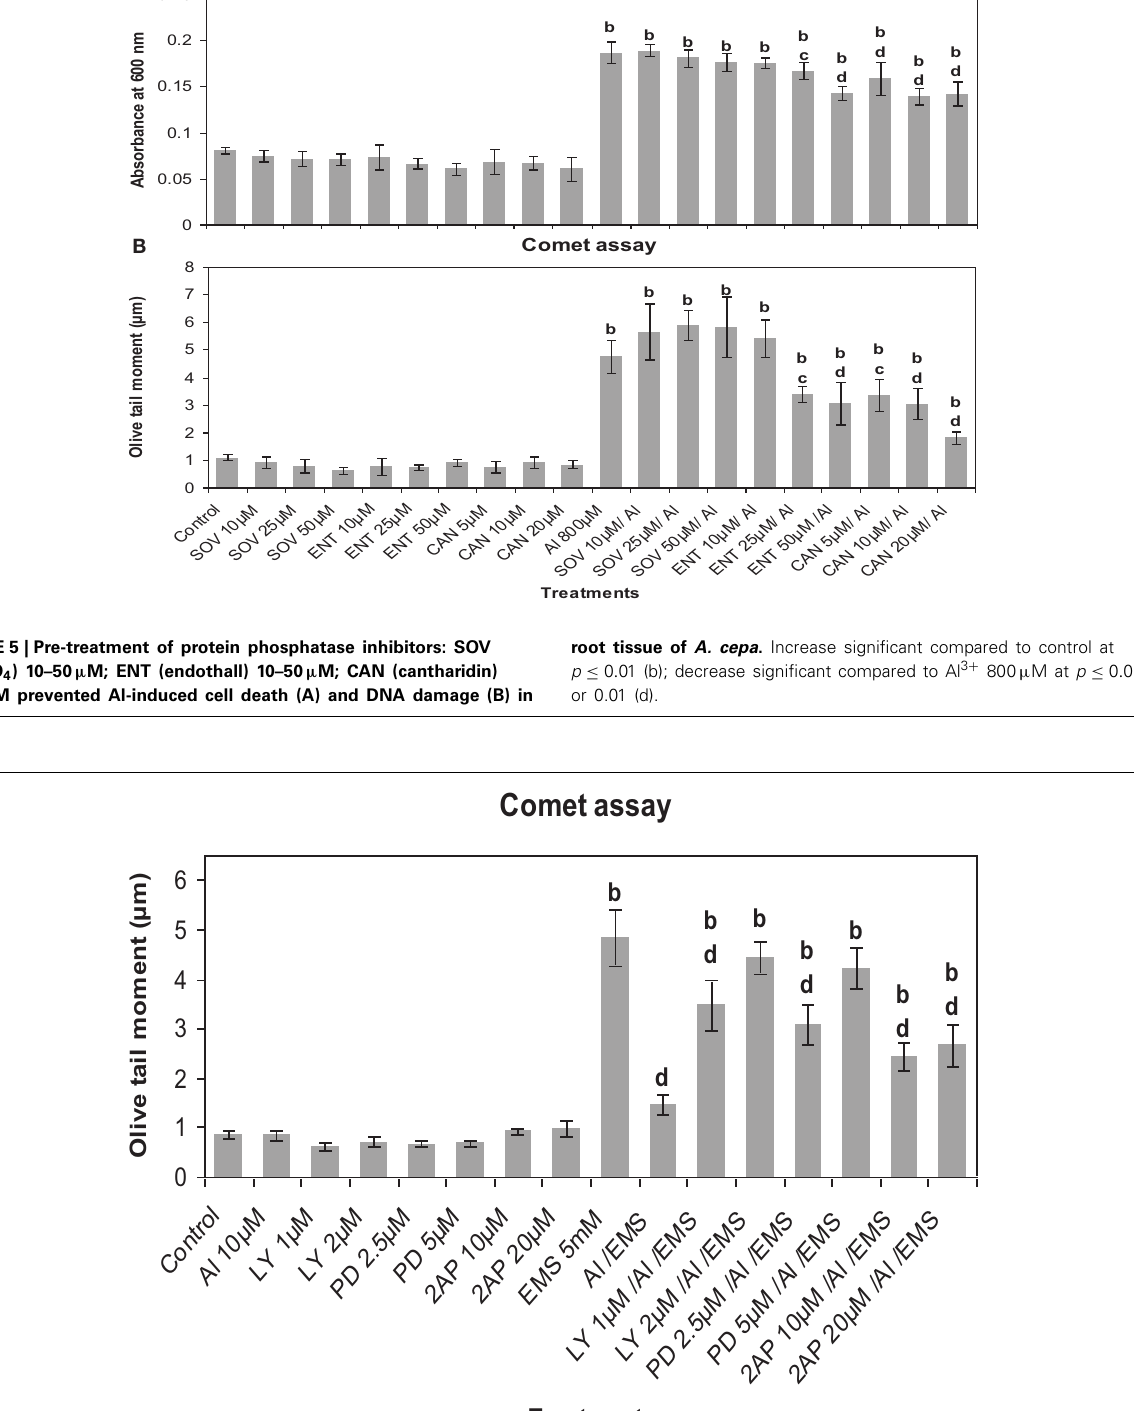
FIGURE 6 | Pre-treatments of protein kinase inhibitors: LY (LY-294002) 1 and 2 µ M; PD (PD-98059) 2.5 and 5 µ M; 2-AP (2-aminopurine) 10 and 20 µ M, prevented Al-induced adaptive response to DNA damage